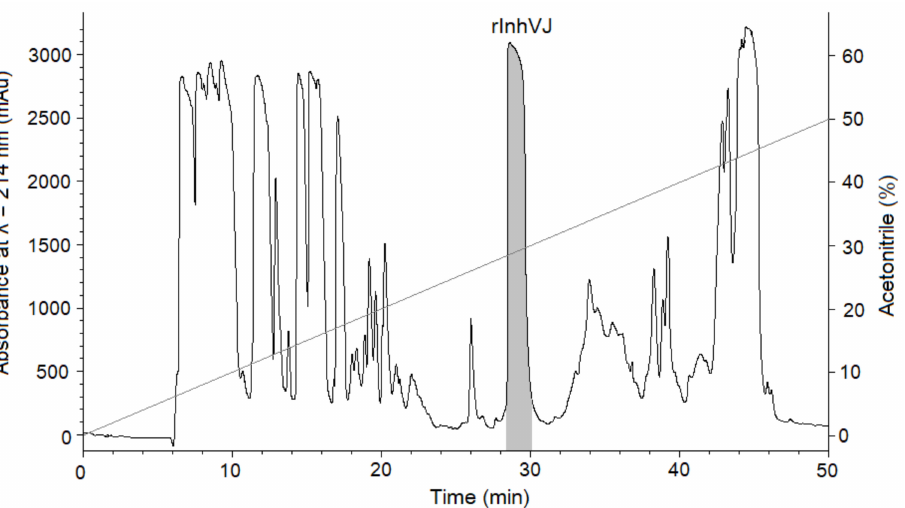
Figure 1. Elution profile of peptides after BrCN digestion of recombinant IhnVJ fusion protein on Jupiter C 4 column (Phenomenex, USA) in a linear gradient of buffer B (0–50%) at a flow rate of 3 mL/min for 50 min. The fraction containing the InhVJ is filled with a light grey